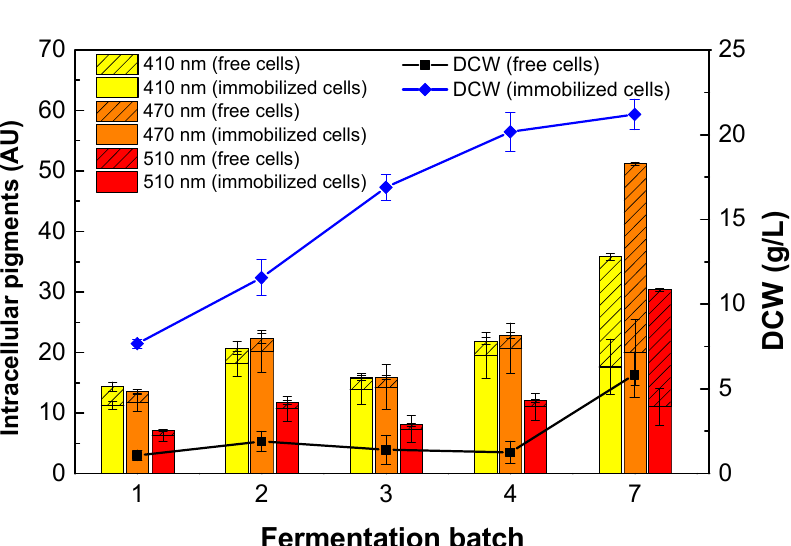
Figure 5. Spectra of extracellular pigments at the end of each batch in repeated-batch extractive fermentation with immobilized cells.